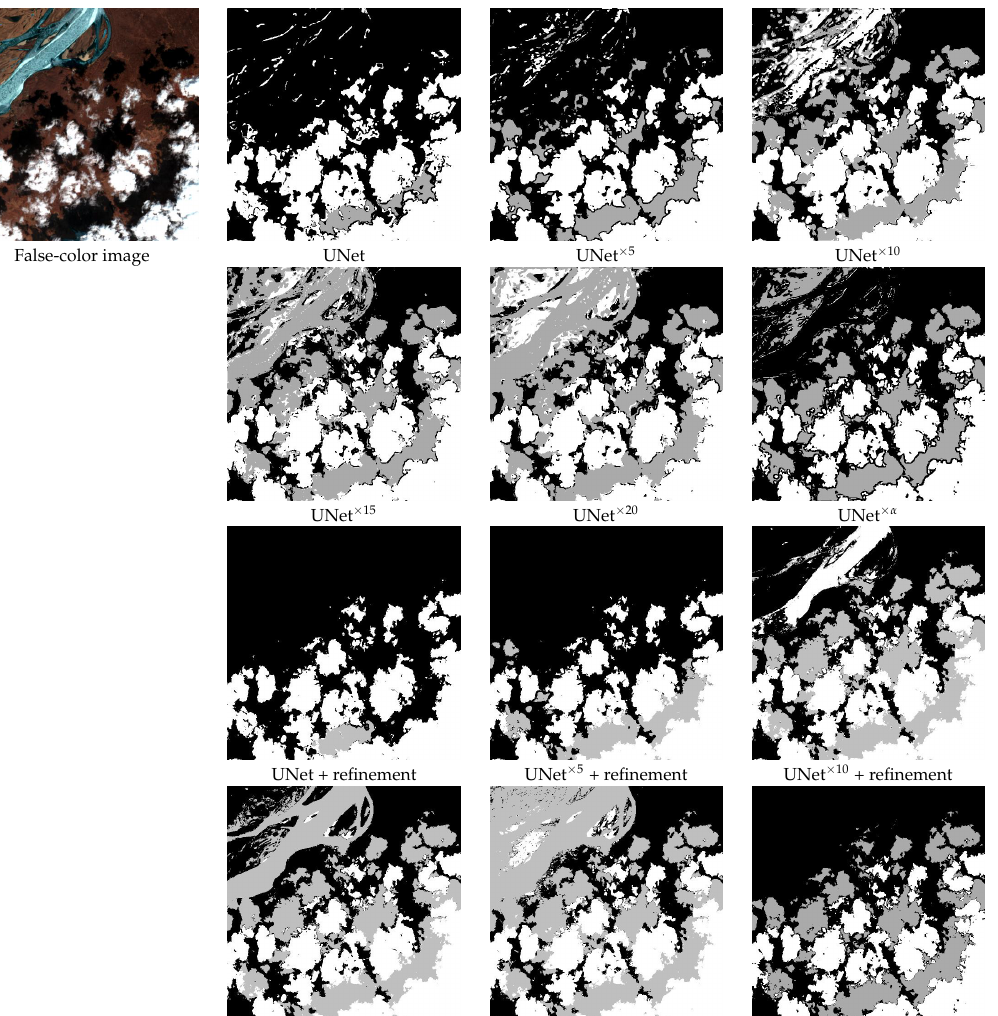
Figure 14. Effect of the fixed and adaptive classification weights in local areas (L8, Path 113, Row 26). Bands 5 NIR, 4 Red, and 3 Green are combined together as RGB channels to construct a false-color image for visualization. We zoom into some local areas to observe the differences between classifiers driven by fixed weights of × 5, × 10, × 15, and × 20 and the adaptive weight × α